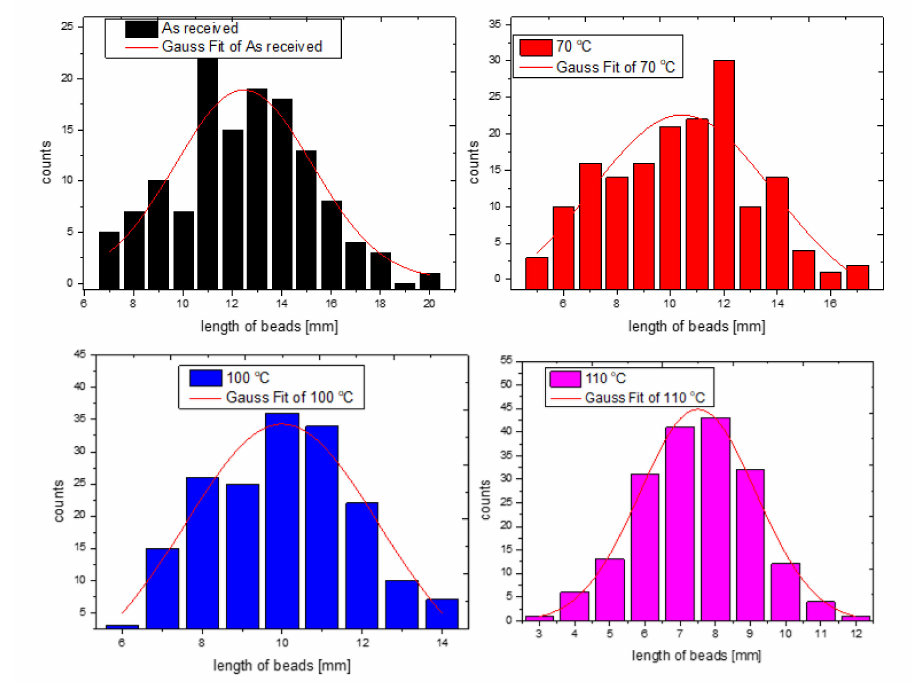
Figure 5. The results of the beads analysis with box chart